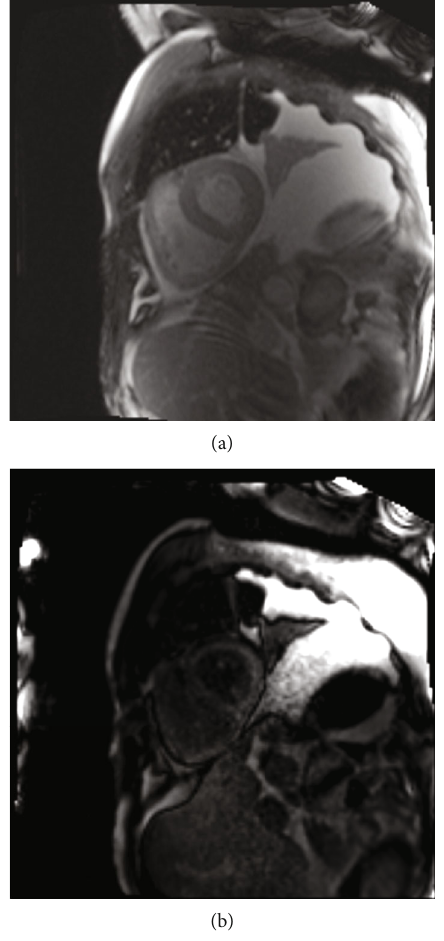
Figure 4: Cardiac magnetic resonance; (a) left ventricle hypertrophy, (b) abnormal nulling of the